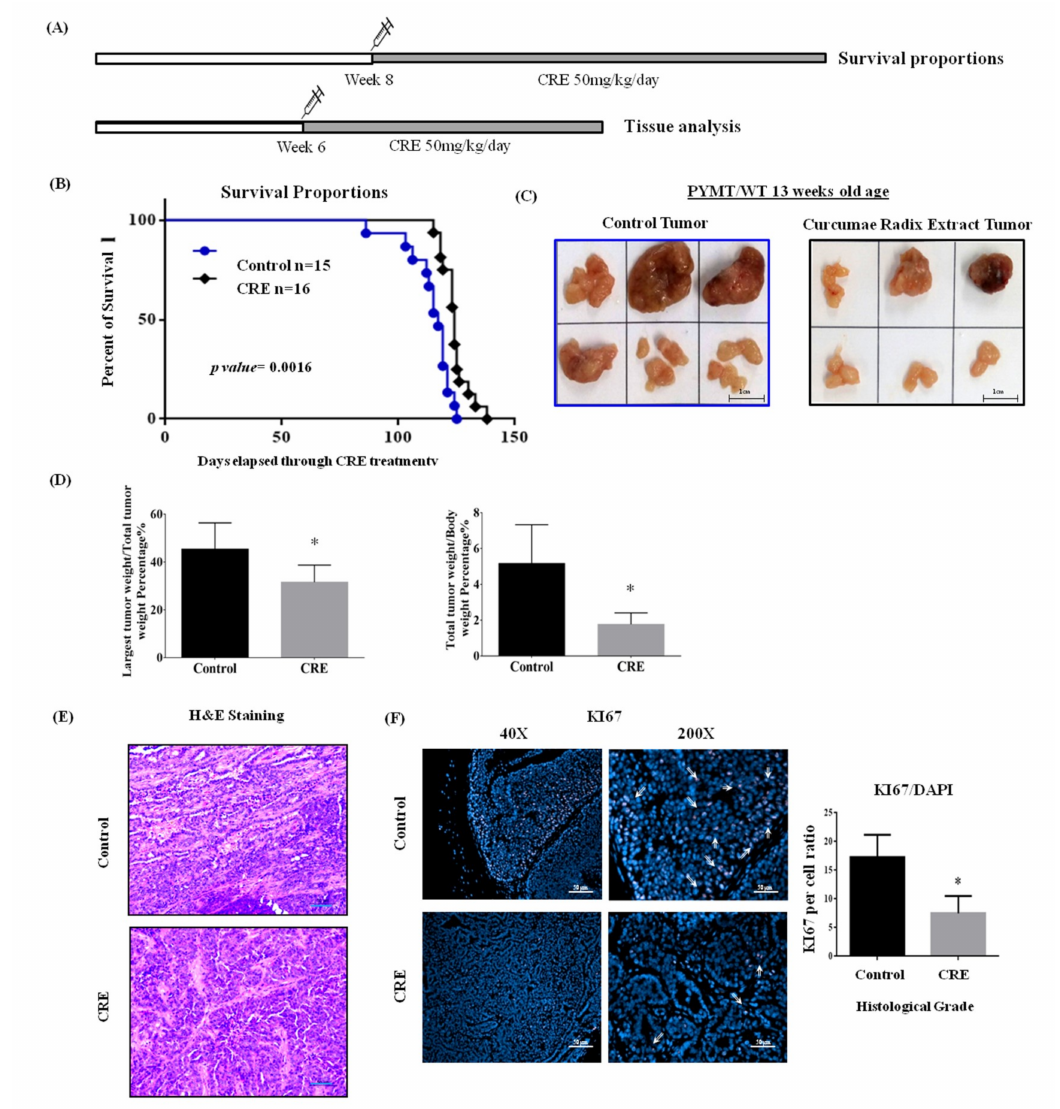
Figure 3. Ethanol extract of Curcumae radix prolongs survival rates of MMTV-PyMT transgenic mice. ( A ) For survival experiment, CRE administration was started at 8 weeks of age and continued until death of animal. For short term analysis, CRE administration was started at 6 weeks of age and mice were sacrificed at the beginning of 13 weeks. ( B ) Graphic represents Kaplan–Meier survival analysis over time with control vs. CRE treatment. The p -value was determined by using log–rank test. ( C ) Gross appearance of excised tumors at 13 weeks of age PyMT transgenic females with/without CRE treatment. Representative images of tumors excised from control and CRE group. Increased tumor size and larger necrotic areas were observed in the tumors excised from control group. ( D ) Total tumor weight and single largest tumor weight significantly decreased in CRE treated PyMT transgenic female mice. Values represent means ± S.E.M. * p < 0.05 vs. control. ( E ) Representative histological images taken of tumors derived from 13 weeks of age PyMT transgenic females with/without CRE treatment. Slides were microscopically examined and images taken. There was no significant difference at tumor grade and malignant progression between each group. Histologically, the tumors were carcinomas ranges from low to medium grade. Scale bars = 50 µ m. ( F ) Curcumae radix extract suppressed cell proliferation in vivo. Immunohistochemistry staining against Ki67 in tumor tissues was done and representative images of tissue sections from each group were taken at 200 × and 40 × magnification. Scale bars = 50 µ m. Histogram data was presented as mean ± SEM. * p < 0.05 vs.